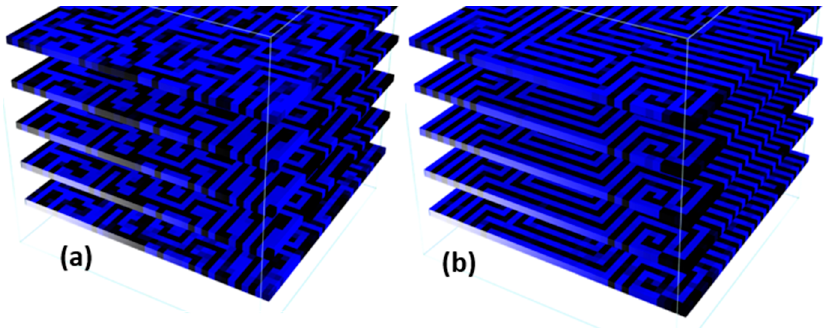
Figure 8. Layered detail ( a ) K = 0.3, J = 0.5; ( b ) K = 0.3, J = 1.0. Blue indicates magnetic alignments in the − x direction and black indicates alignments in the + x direction.